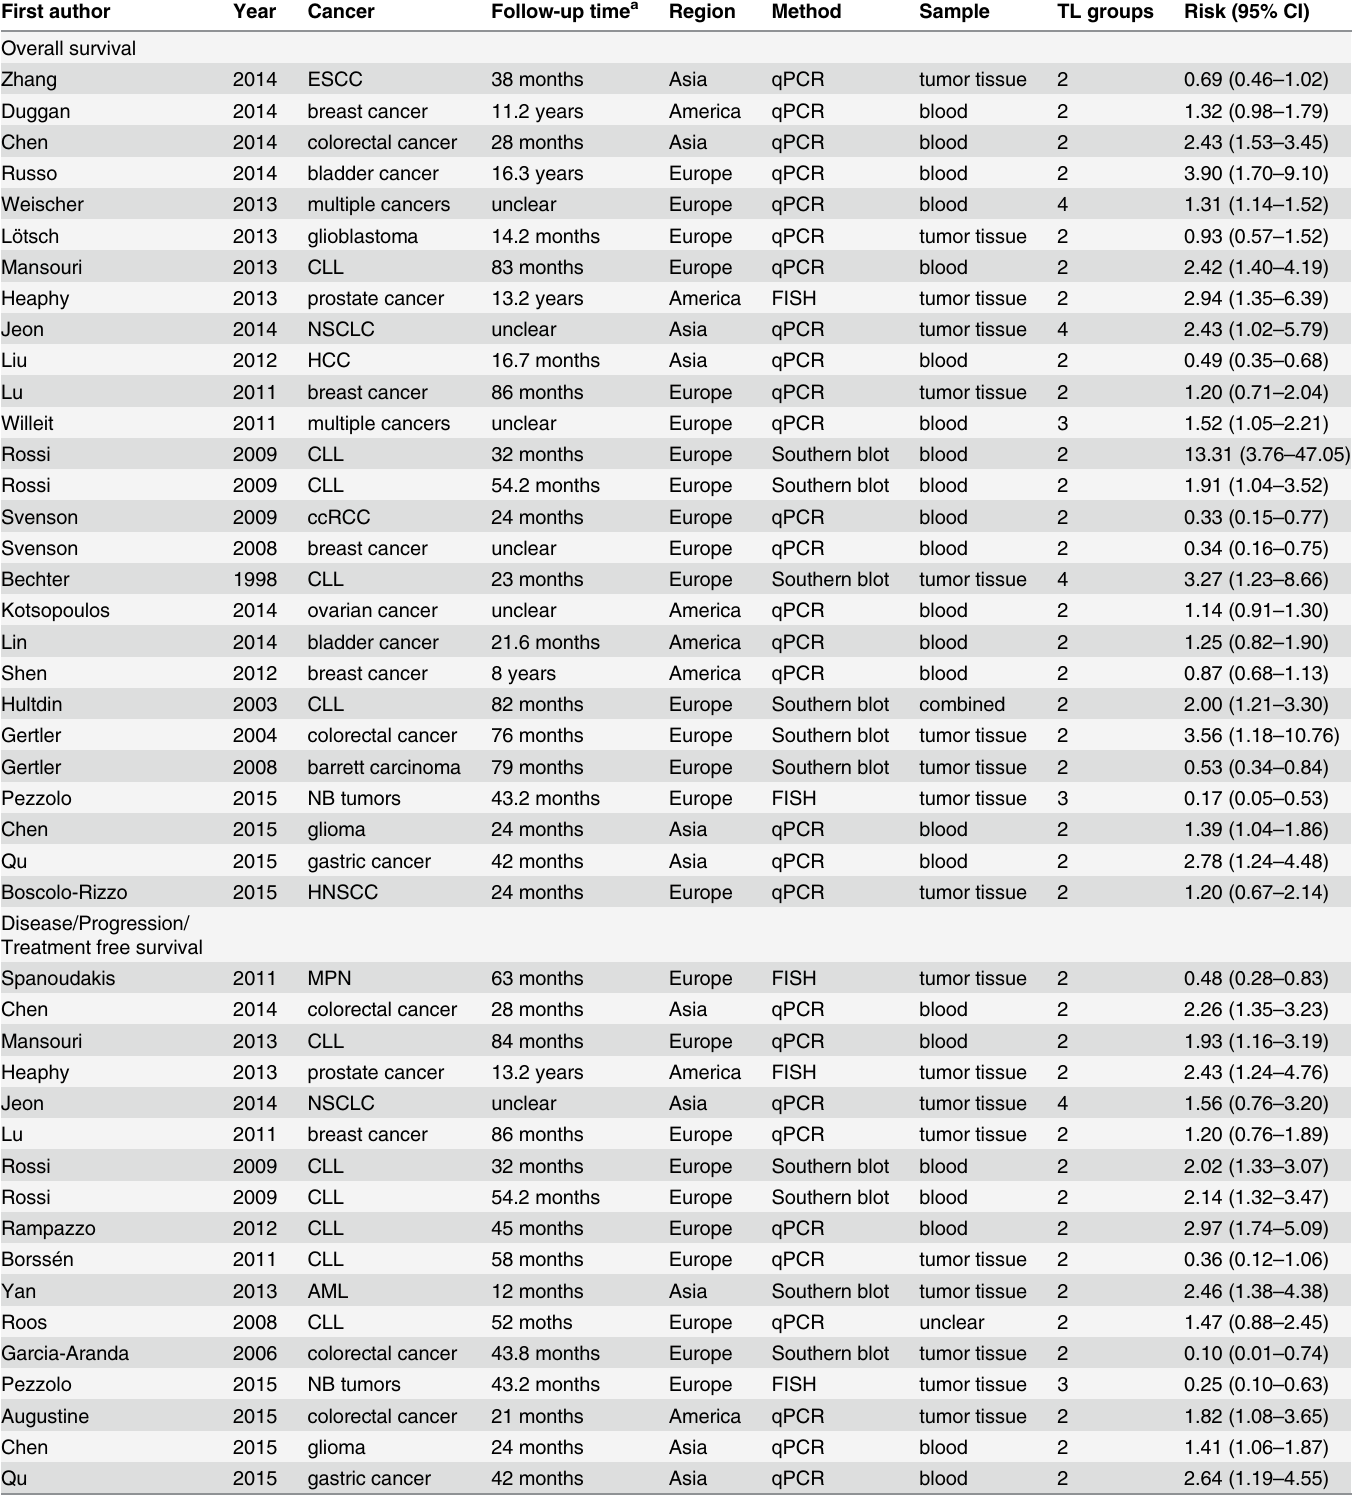
Table 1. Characteristics of included